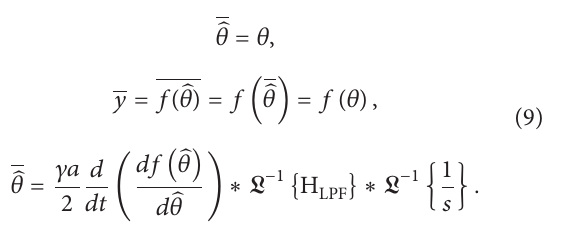
Figure 7: Averaged BICO-ESC